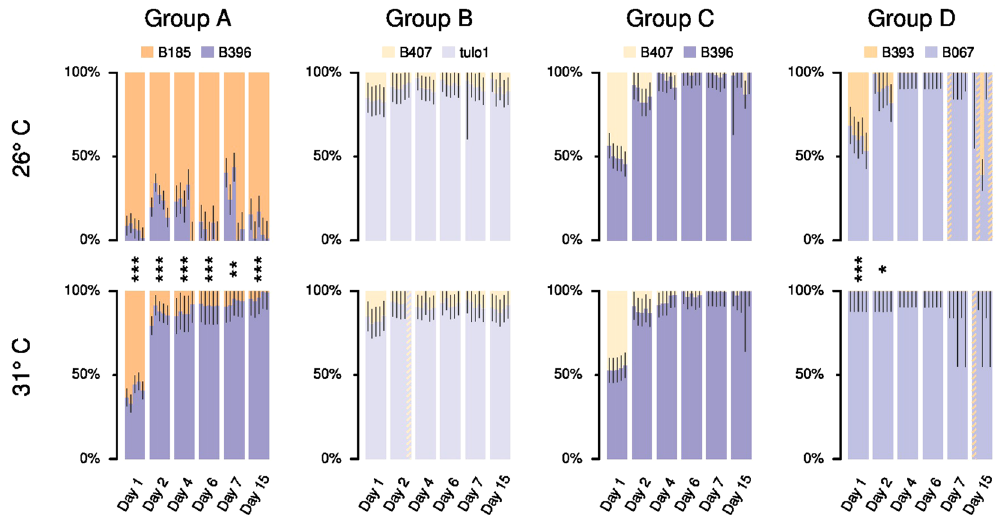
Figure 3. Genotype proportions estimated by HRM runs after 1, 2, 4, 6, 7 and 15 days of competition in liquid medium. For each day, vertical bars show the relative proportions of each competing genotype in five experimental replicates within each competition group (A, B, C and D) and black lines indicates the 90% confidence interval for each proportion estimate based on the triplicate HRM samples. The ordering of experimental replicates in the bar plots are the same from day 1 to day 15 within each group × temperature treatment. The names of the competing genotypes are indicated on the vertical axes. Hatched bars indicate replicates for which HRM data could not be used to estimate genotype proportions. For each day within each competition group, symbols between the 26 °C and 31 °C bar plots indicate the p-values of a Welch’s t-test comparing the genotype proportions for the 26 °C replicates and for the 31 °C replicates ( *** < 0.001 < ** < 0.01 < * <